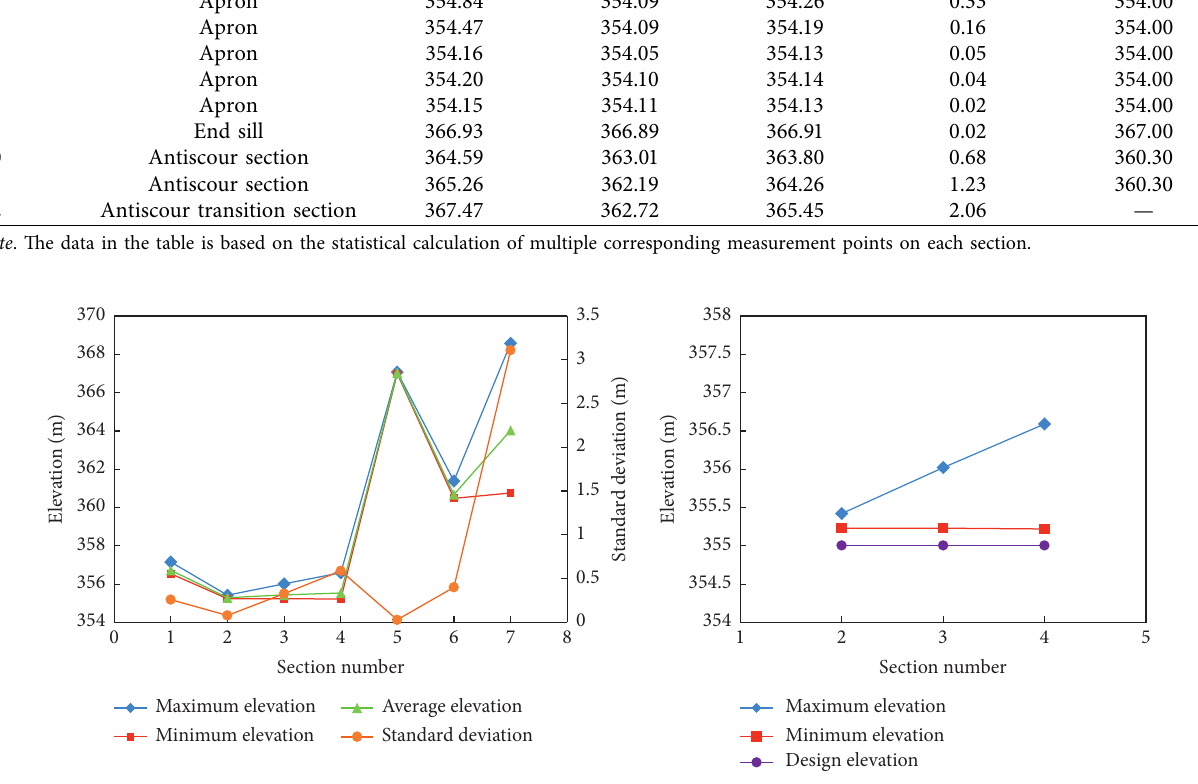
Figure 11: Comparison diagram of section elevation of the surface outlet stilling basin. (a) Diagram of section elevation and standard deviation. (b) Section elevation change of stilling basin